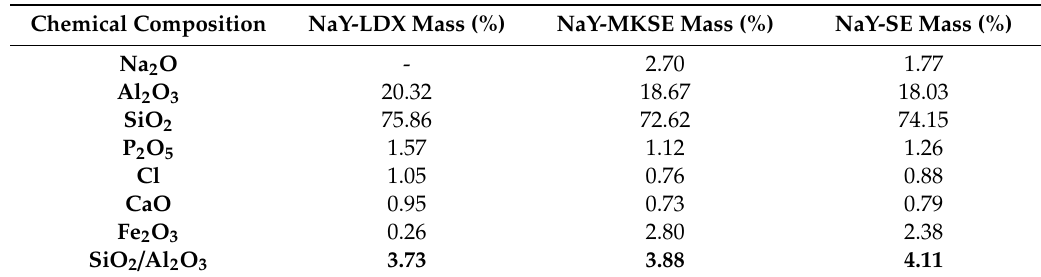
Table 2. Chemical composition of NaY zeolites.